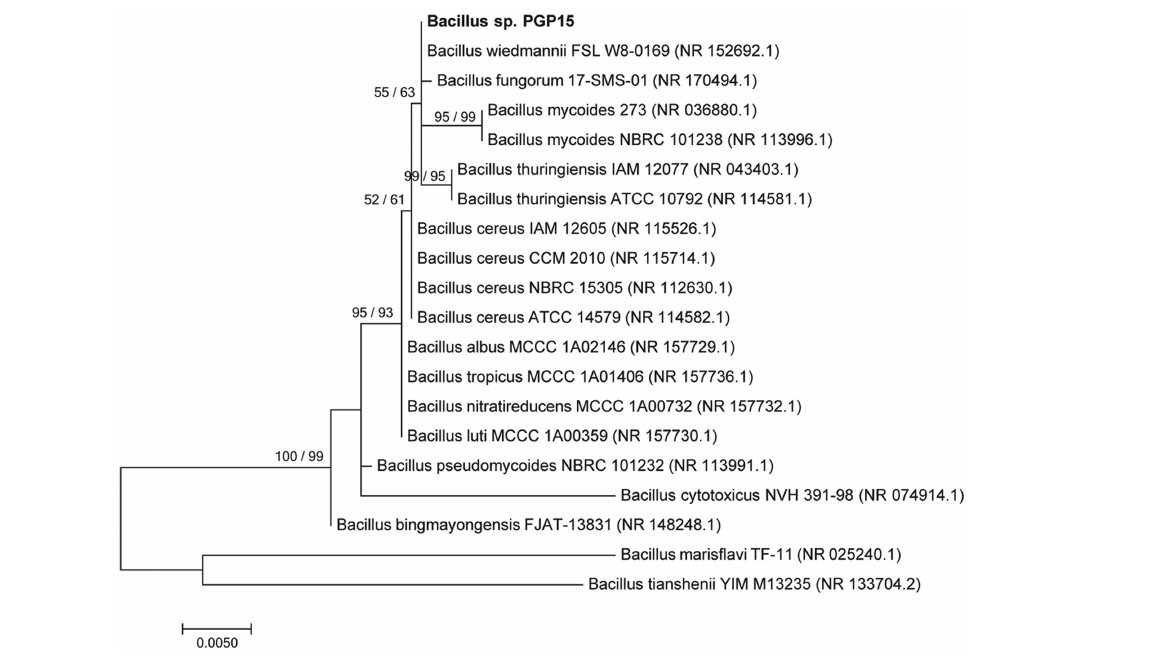
FIGURE 1 | Phylogenetic relationships between strain PGP15 and related species showing the position of strain PGP5 within the genus Bacillus . The maximum likelihood (ML) phylogenetic tree based on 16S rRNA gene sequences is shown. The ML and neighbor-joining bootstrap values based on 1,000 replications are sequentially indicated above the branches. Bar, 0.005 substitutions per nucleotide